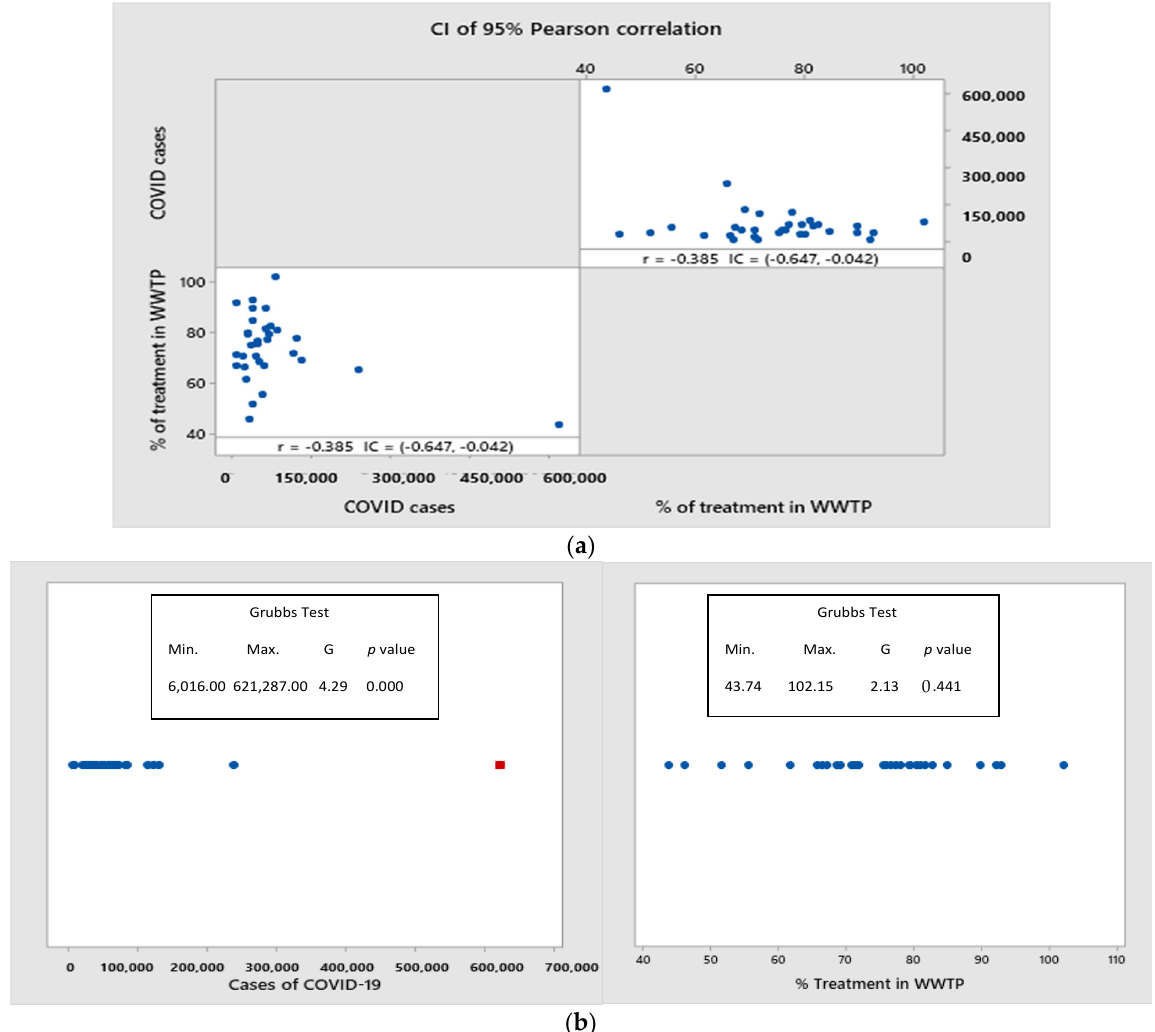
Figure 5. ( a ) Graphic correlation between positive cases of COVID-19 and percentage of treated wastewater in Mexico. ( b ) Grubbs test to determine outliers of positive cases of COVID-19 and percentage of treated wastewater in Mexico.